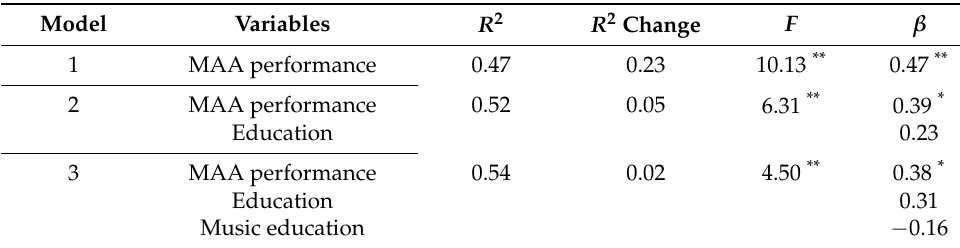
Table 6. Comparison of the MR